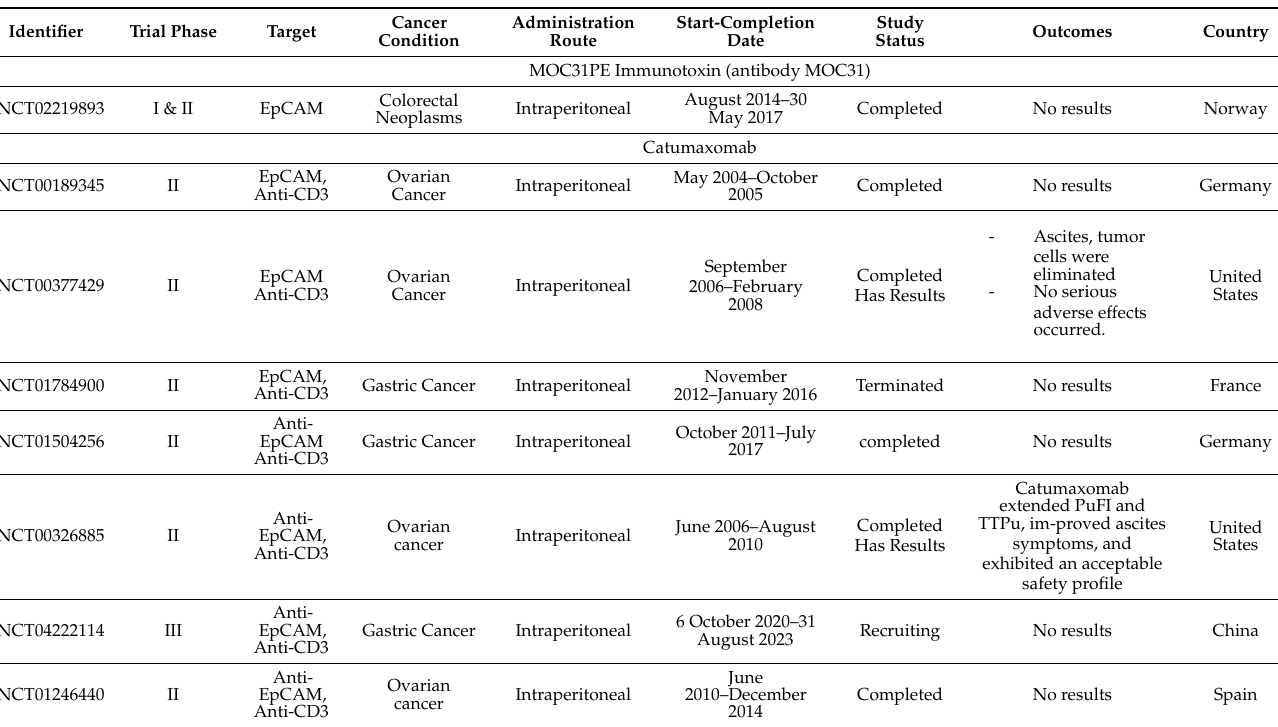
Table 2. Active clinical studies using monoclonal antibodies for PC (retrieved on 25 February 2023) from